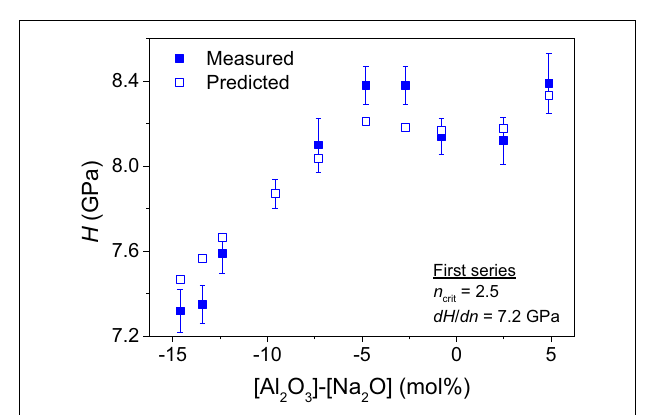
FIGURE 1 | Composition dependence ofVickers hardness ( H ) for the first series of boroaluminosilicate glasses: (80 − x )SiO 2 − x Al 2 O 3 − 5 B 2 O 3 − 15 Na 2 O with x = 0, 1, 2.5, 5, 7.5, 10, 12.5, 15, 17.5, and 20 (Zheng et al., 2012b). The filled squares represent the experimental data points, whereas the open squares represent the computed H ( x ) values with Eq. 1 ( dH / dn = 7.2GPa) using the analyzed compositions and 11 B and 27 Al MAS NMR data (Zheng et al., 2012a).